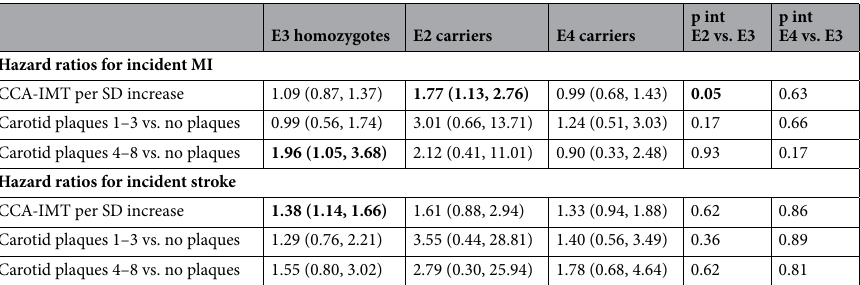
Table 4. Modification of associations between carotid artery measures of intima-media thickness and plaque at baseline and risk of incident MI and stroke by APOE allele status. Significant associations are shown in bold font. Model adjusted for age, sex, baseline values of body mass index, smoking status, alcohol consumption, sedentary lifestyle, hypertension and type 2 diabetes, low-density lipoprotein and high-density lipoprotein cholesterol. p int p value of interaction, CCA-IMT common carotid artery intima-media thickness, SD standard